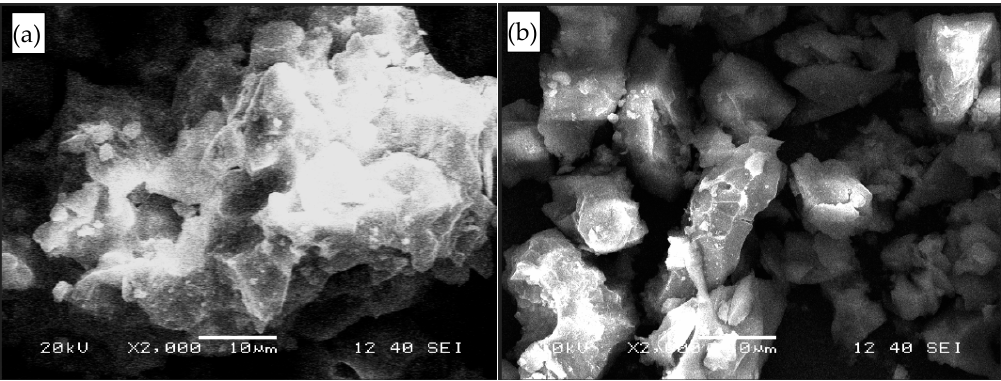
Figure 7. SEM images of antimony ore waste rocks at different periods ( a ) before leaching; ( b ) after leaching.